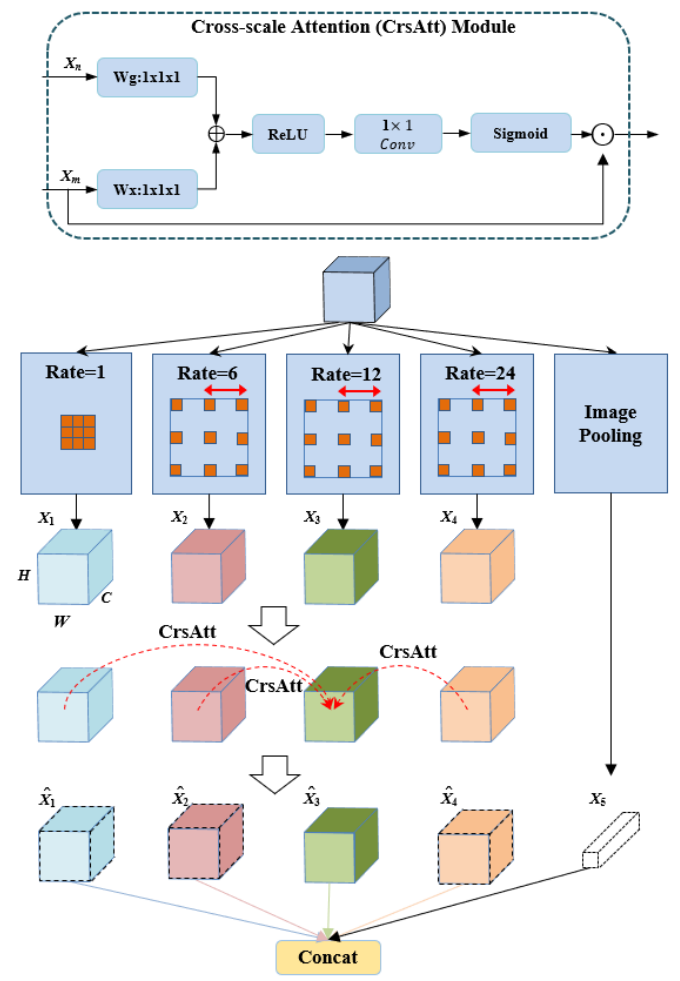
Figure 6. Structure of the proposed adaptive-ASPP module. It is designed to adjust the combination weights for varied contents in a feature-embedded space by using the proposed cross-scale attention (CrsAtt) module (top). Image Pooling represents a global average pooling